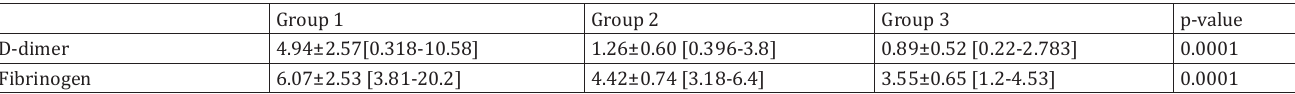
Sensitivity and specificity of D-dimer and fibrinogen in patients with COVID-19